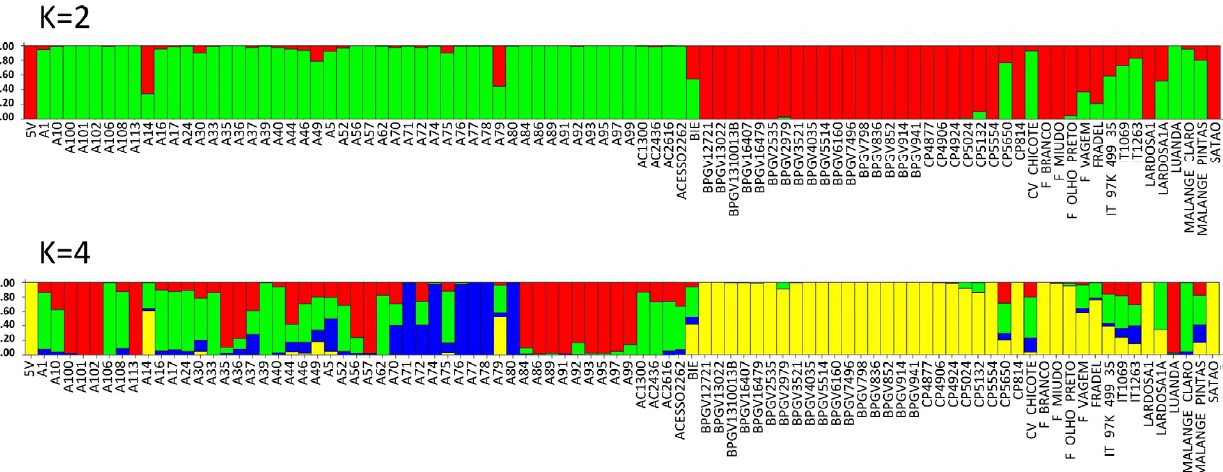
Figure 7. Population STRUCTURE of 92 cowpea accessions using SilicoDArT marker data as esti- mated using the model-based Bayesian algorithm implemented in the STRUCTURE program. Proportion of assignment of individuals to K = 2 and K = 4 subpopulation groups. Each accession is represented by a vertical line. Vertical lines with only one color (higher than 80%) were considered pure accessions.